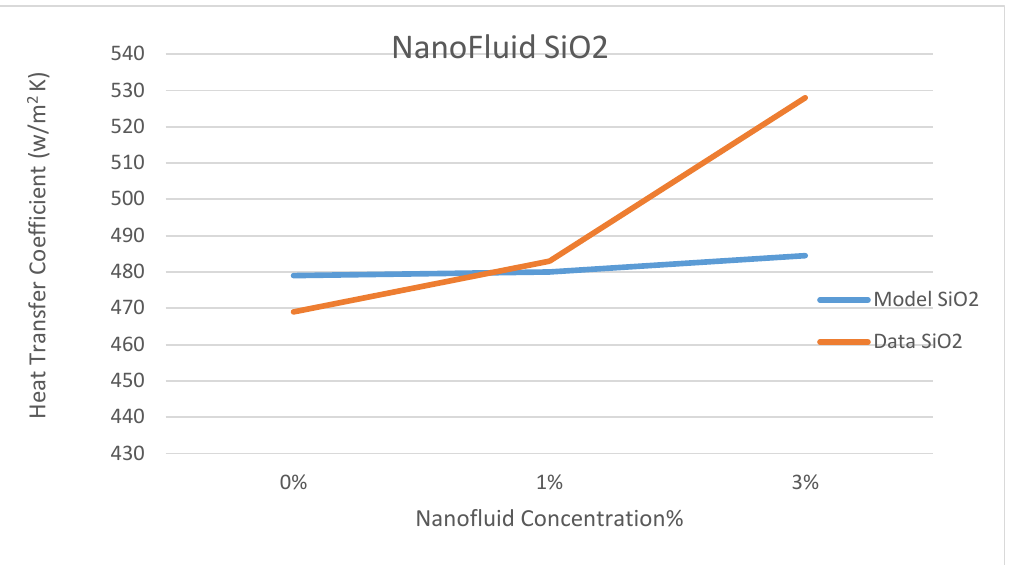
Figure 34. Comparison between model and data of Marefatoi et al. [31] for Al 2 O 3 as in text is (Al 2 O 3 ) and applies to all other Figures.